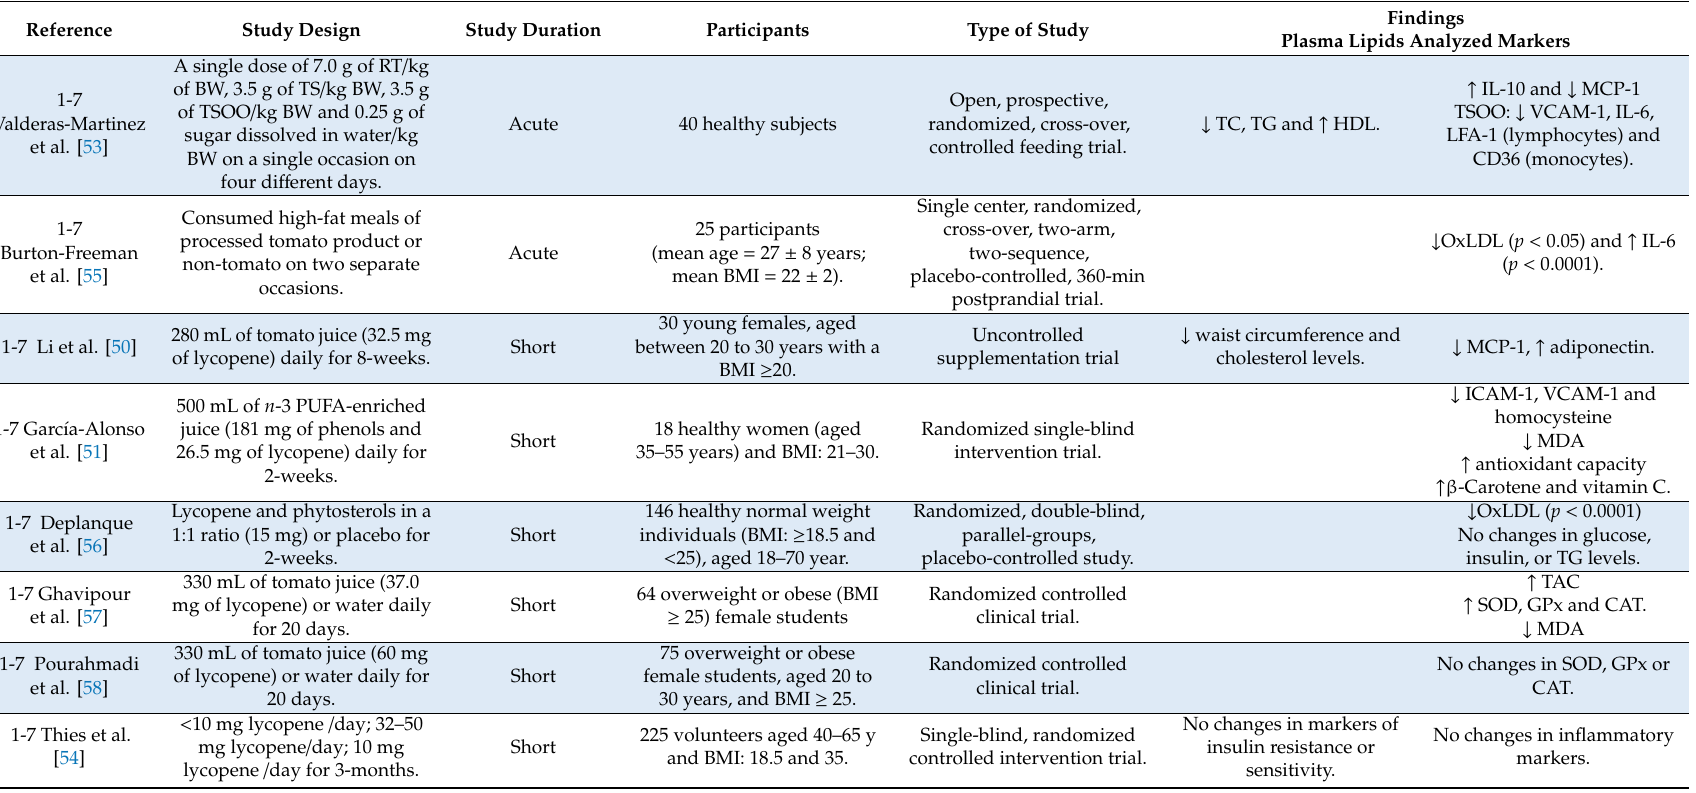
Table 1. Potential protective e ff ect of tomatoes or their bioactive compounds on proinflammatory and oxidative stress markers during the progression of